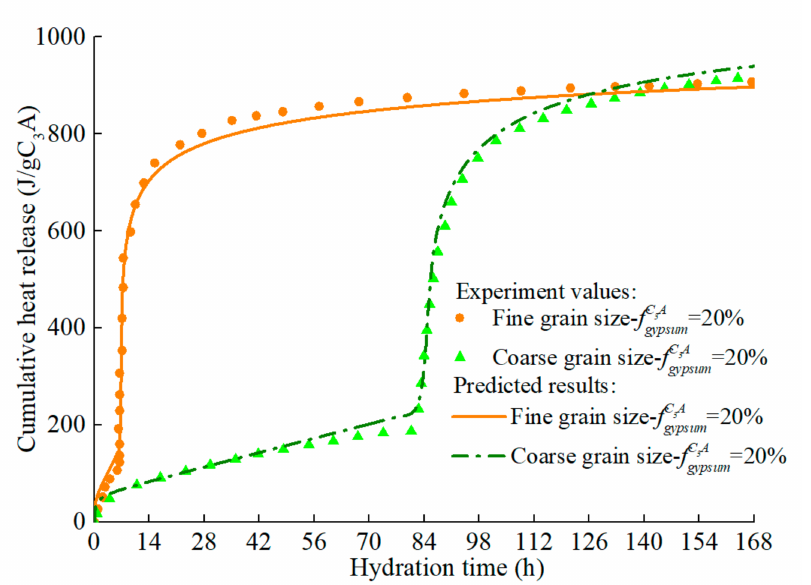
Figure 17. Hydration heat of C3A in C3A-gypsum system with different fineness (w/c =